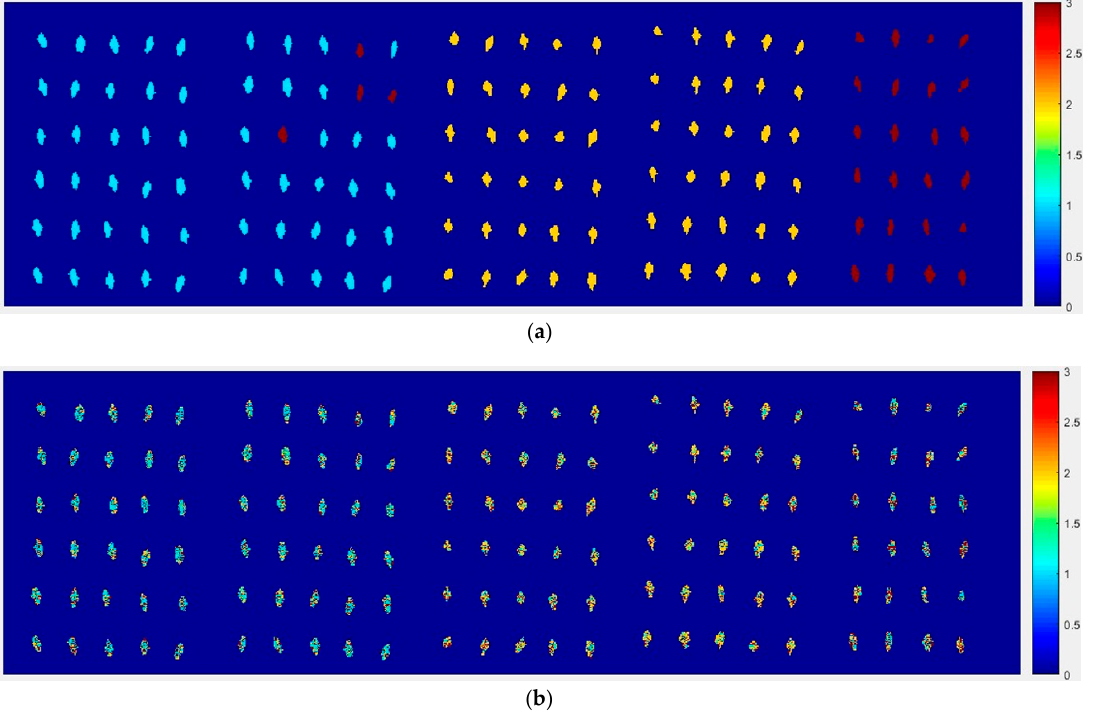
Figure 12. The final visualization images of Haihe78 with the SPA and PLS-DA model with method M2P.